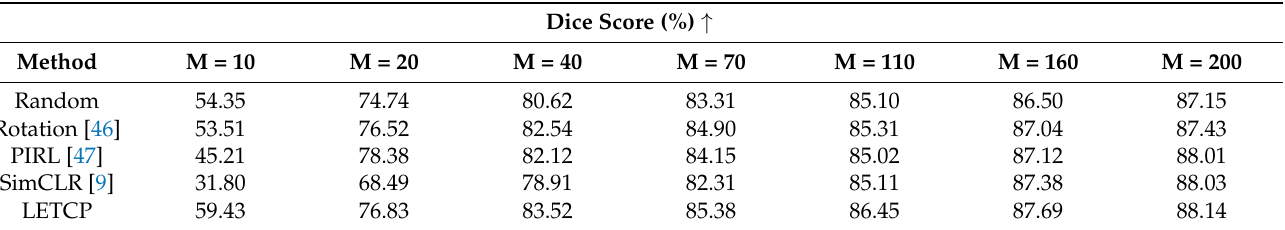
Table 2. Comparison of the proposed LETCP method with baseline methods on BraTS 2020 [1–3]. ↑ means higher is